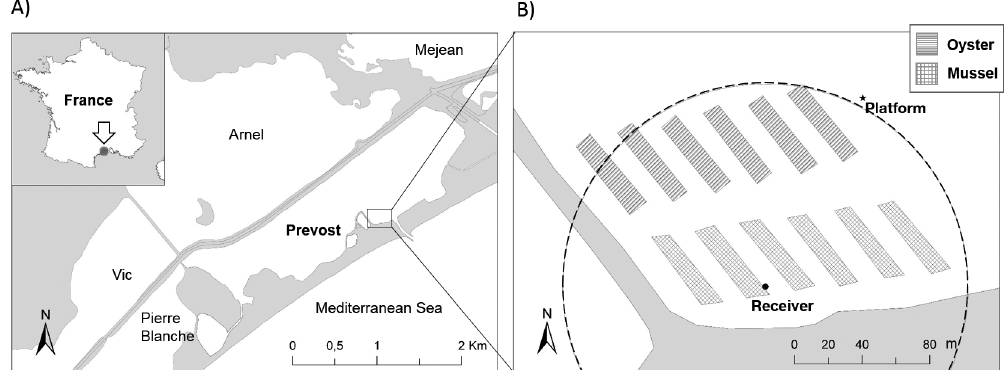
Fig. 2. (A) Prevost Lagoon, southern France, and (B) the bivalve farm comprising 12 tables: 6 of mussels and 6 of oysters, one of which (stocking bag) held market-ready oysters rather than grow-out ropes. Black dot and star: position of the acoustic receiver and experimental platform, respectively; circle: 50% acoustic detection area. The acoustic receiver and experimental platform were separated by 130